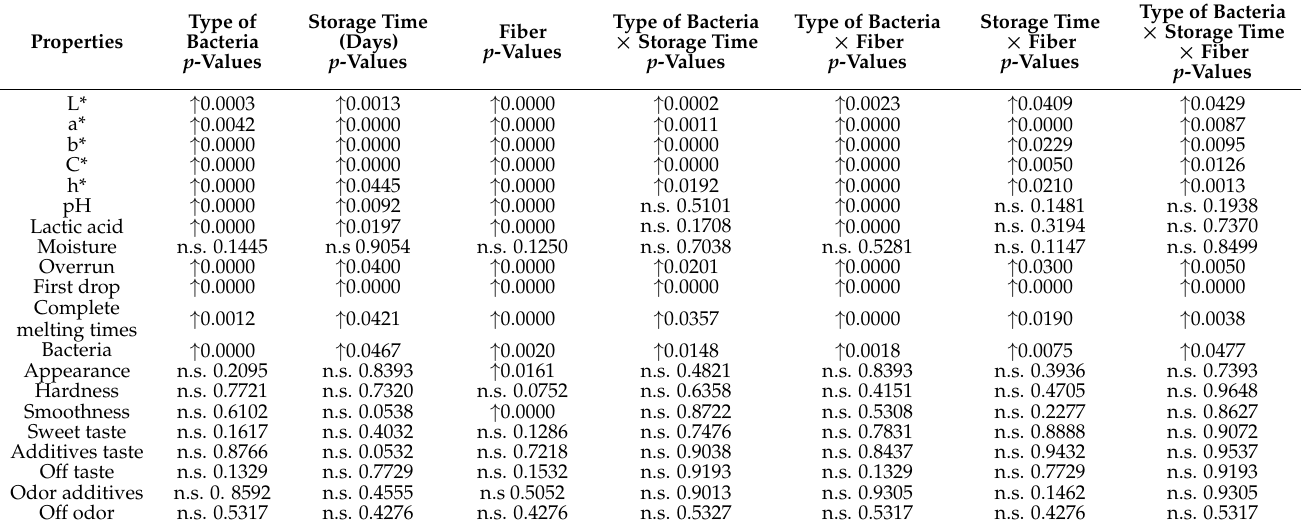
Table 3. Analysis of variance (ANOVA) p -values on the effects of storage time and type of bacteria and fiber on color, pH, lactic acid, overrun, bacteria appearance, hardness, smoothness, sweet taste, additives taste, off taste, odor additives and off odor of ice